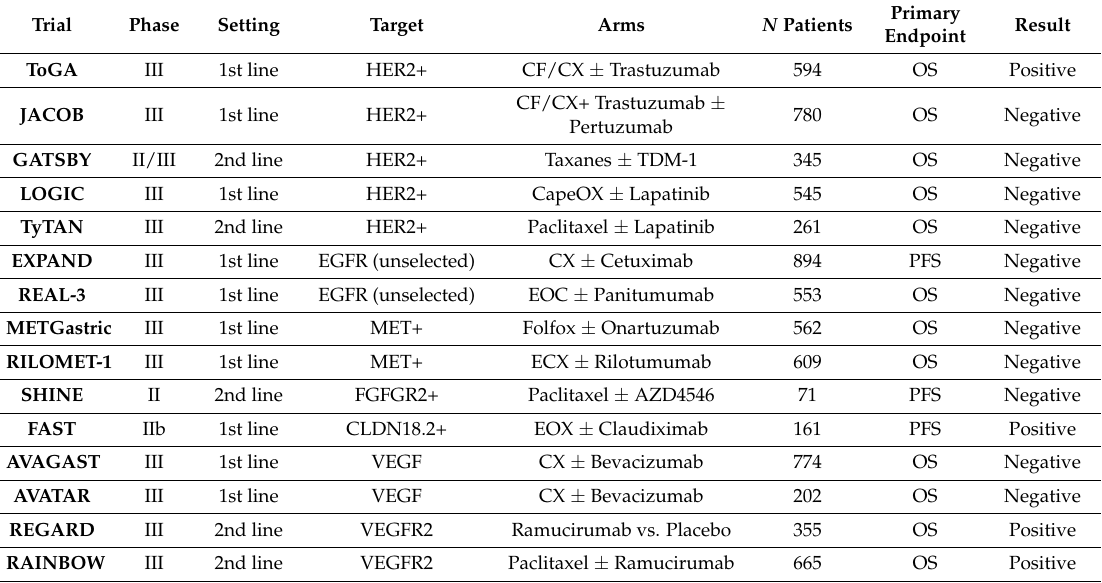
Table 1. Major target-oriented phase II/III trials in gastric and esophagogastric